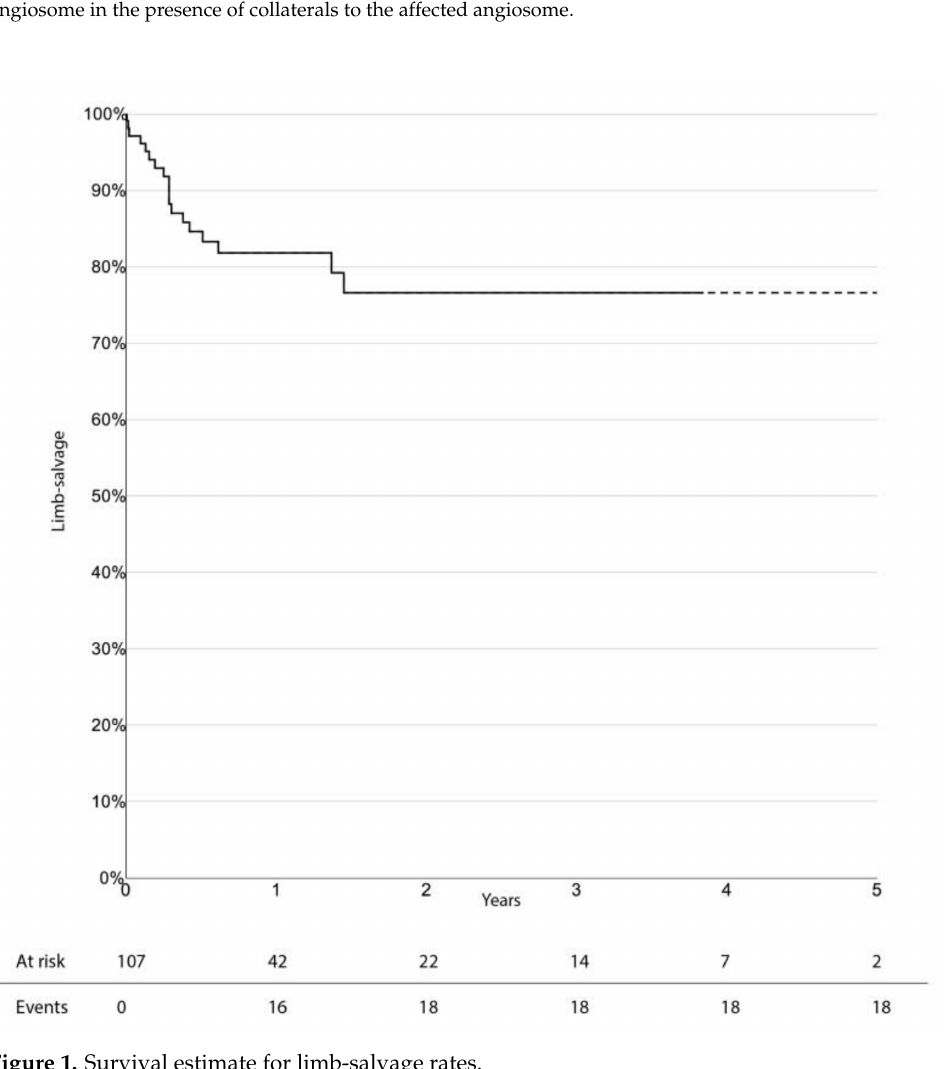
Figure 1. Survival estimate for limb-salvage